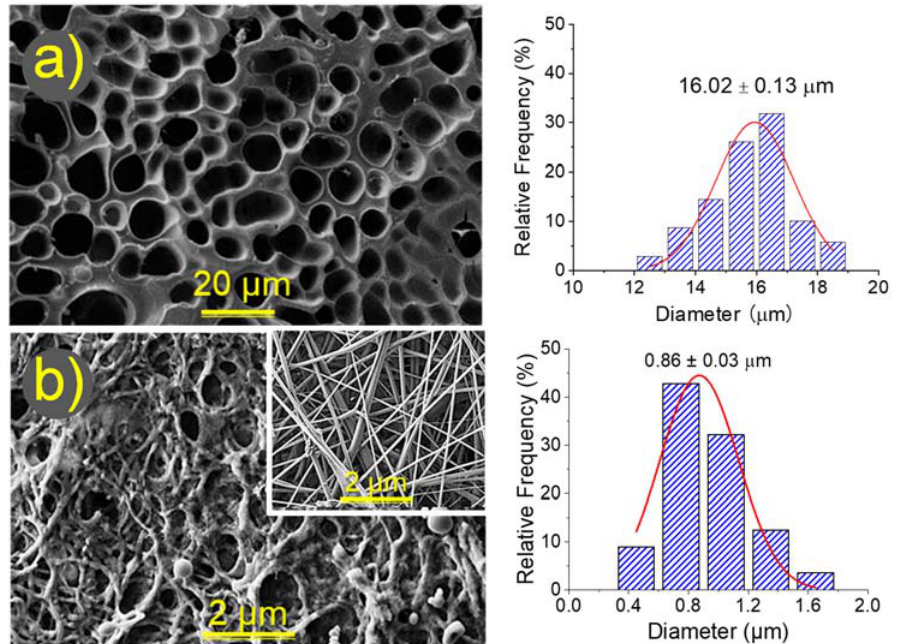
Figure 7. SEM micrographs ( left ) comparing the morphology of hydrogels prepared from the bulk ( a ) and from electrospun nanofibers ( b ) after reaction with the stochiometric ratio of cystamine 100%. In both cases pore diameter distributions are provided ( right ). For comparison purposes, the inset of ( b ) shows the electrospun fibers before performing the crosslinking reaction.